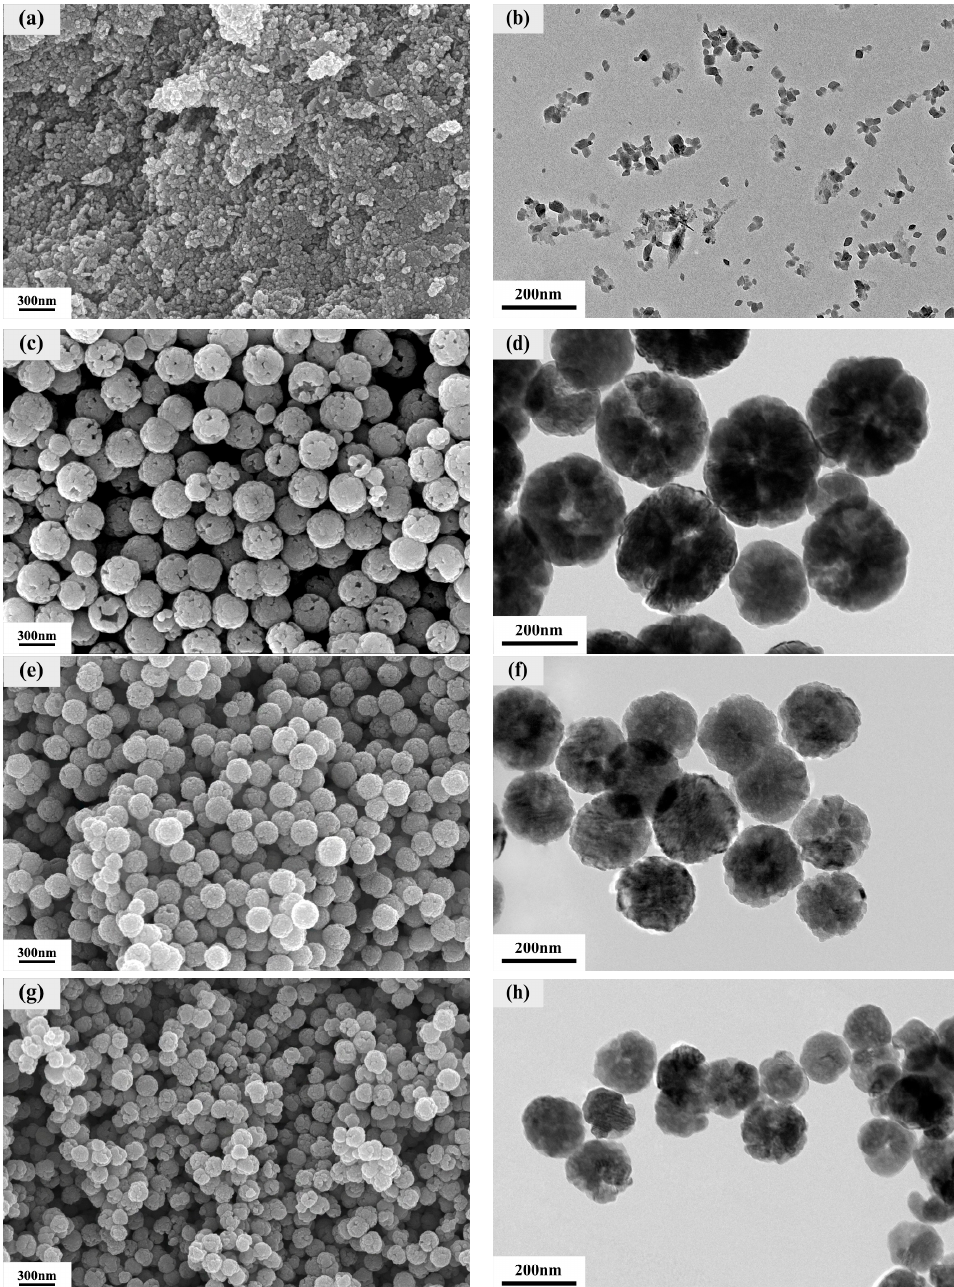
Figure 2. Scanning electron microscope (SEM) and transmission electron microscope (TEM) images of cobalt ferrite for different reaction times. SEM images: ( a ) 4 h, ( c ) 8 h, ( e ) 12 h, ( g ) 16 h; TEM images: ( b ) 4 h, ( d ) 8 h, ( f ) 12 h, ( h ) 16 h.